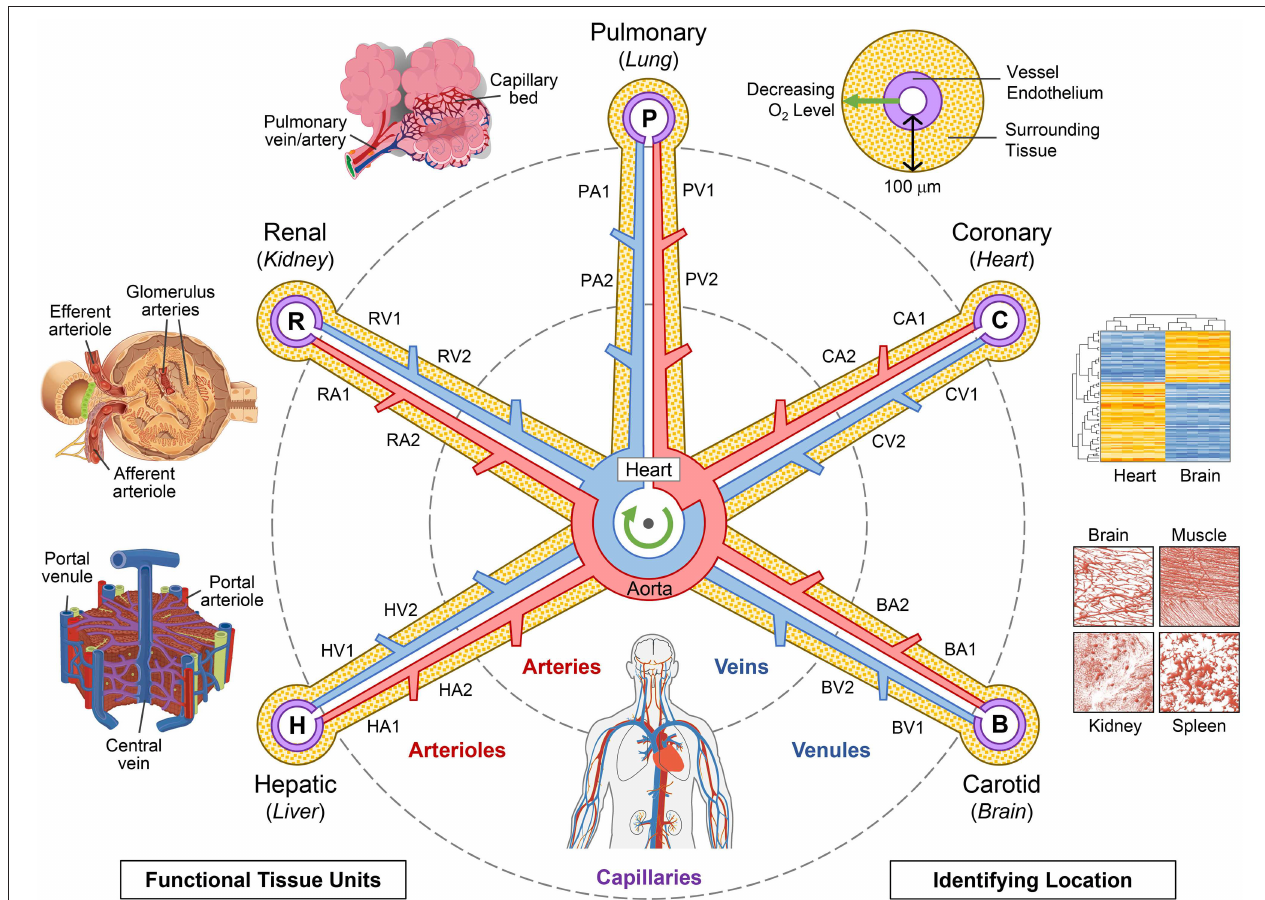
FIGURE 1 | The hub-and-spoke structure of a vascular coordinate system. The vascular coordinate system consists of representative vessel loops that begin and end in the chambers of the heart and extend to the functional units of each organ (counterclockwise from upper-left: alveoli, glomeruli, and hepatic lobules). The “address” of a cell includes of the name of the loop (e.g., “R” for renal and “H” for hepatic) and the branching level of the nearest vessel (e.g., “RA1” for afferent arterioles in the renal loop). Note that the walls of the heart lie along the coronary (“C”) vascular loop, and the cells of some structures internal to the heart are actually positioned on the periphery of the coordinate system, near the capillaries that provide them with blood. There are multiple ways to pinpoint an even more precise “GPS-like” position, including, going clockwise from upper-right, the “hypoxia fingerprint” that results from decreasing oxygen levels farther from the vessel, the unique “histologic fingerprint” and “gene expression fingerprint” in different types of vascular endothelial cells, and the distinctive “vascular architecture fingerprint” found in different types of tissue. The vasculature extends to all parts of the body (bottom) and frames all organs at all scales. Source Files: Images of the hepatic lobules, glomeruli, alveoli, gene expression heat map, and whole body vasculature are adapted from Wikimedia Commons: https://commons.wikimedia.org/wiki/File:2423_Microscopic_ Anatomy_of_Liver.jpg (Public Domain); https://commons.wikimedia.org/wiki/File:Juxtaglomerular_Apparatus_and_Glomerulus.jpg (CC BY 3.0 license);